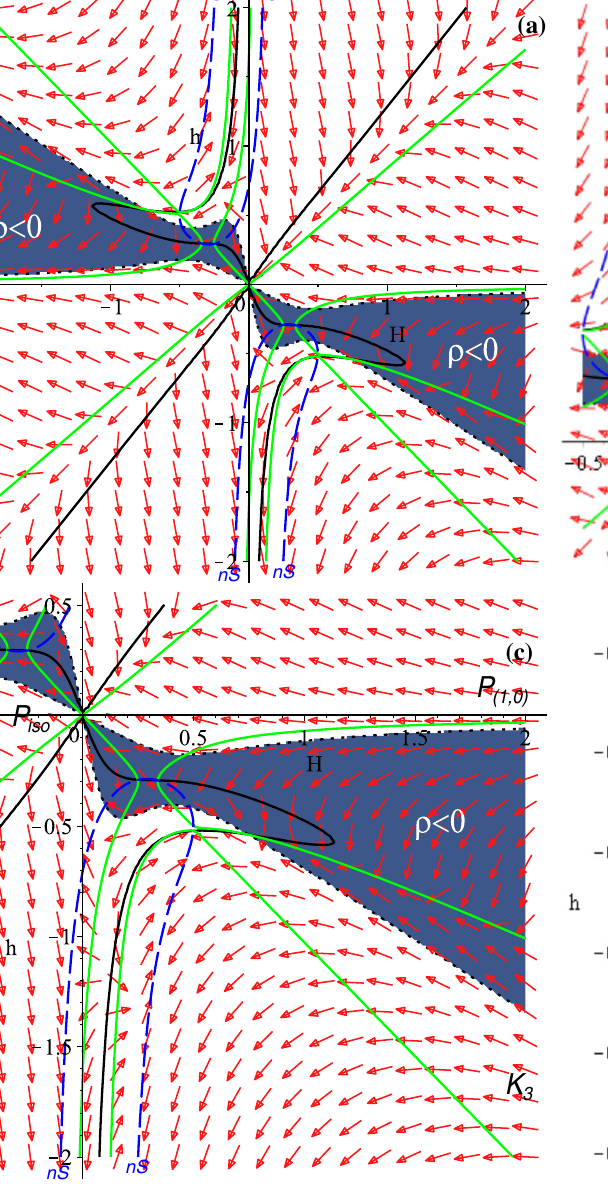
blue area corresponds to the unphysical ρ < 0 initial conditions. Green curve points location of ˙ h = 0, black – ˙ H = 0 and dashed blue – to nonstandard singularities (see the text for more